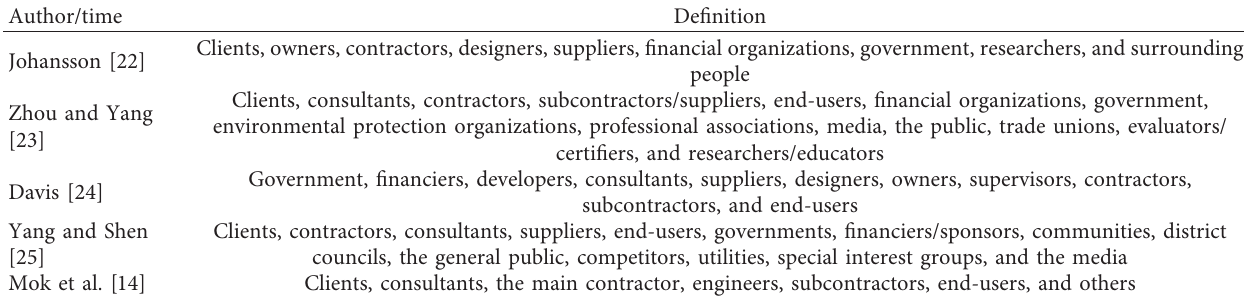
Table 1: Definition of stakeholders in construction projects by different scholars.